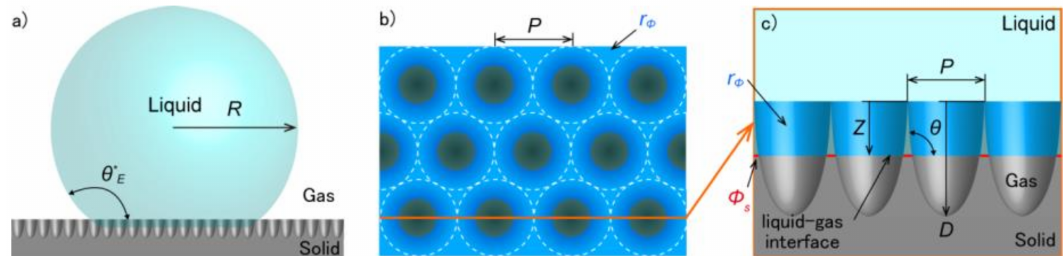
Figure 4. Schematic diagram of a liquid droplet on a textured surface similar to the inverted moth-eye structure, showing the parameters used to calculate the GFE density: ( a ) side-view, ( b ) enlarged top-view, and ( c ) enlarged side-view corresponding to the line in the top-view. Areas in deep blue indicate the ratio of the actual wetted area to the total solid area of the textured surface ( r φ ), and red areas indicate the ratio of the actual area of liquid-solid contact to the projected area on the horizontal plane ( φ s